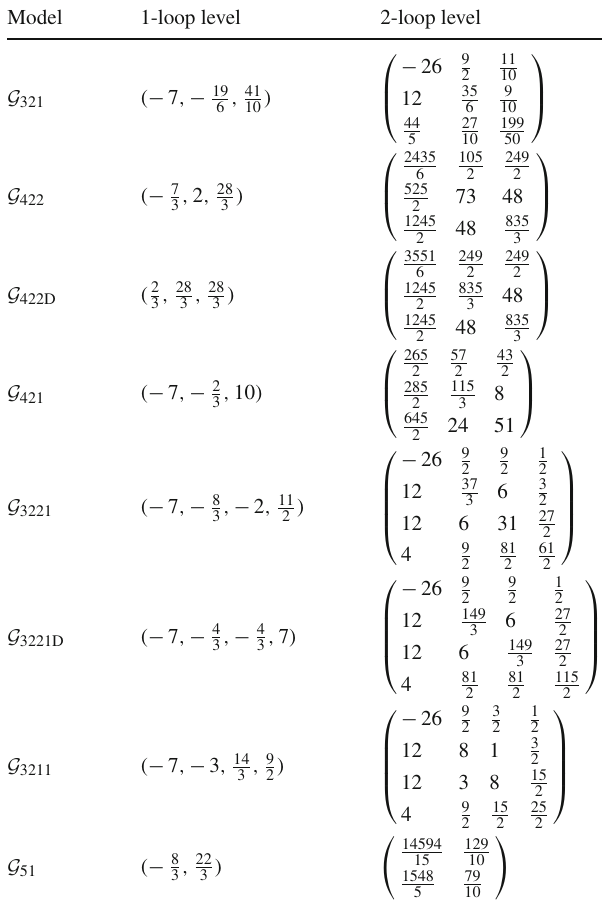
Table 2 β coefficients at one-loop and two-loop levels in each of the eight models considered. The order in which the β functions for each model are listed is the same order in which the gauge group factors are listed, following the conventions in the rest of this work Model 1-loop